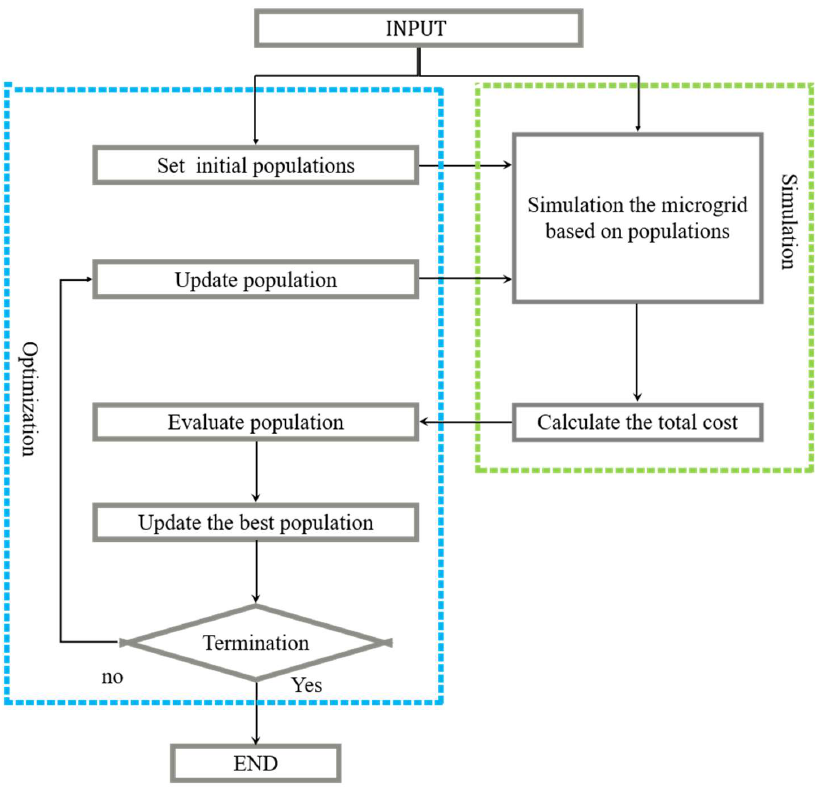
Figure 17. The interrelationship between the simulation and optimization models.